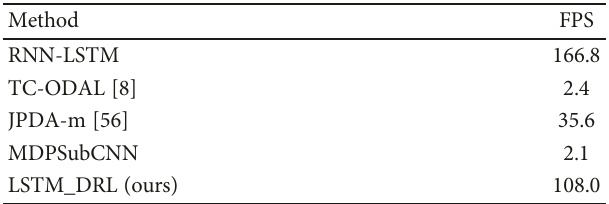
Table 2: The running time comparison results of our tracker with other state-of-the-art